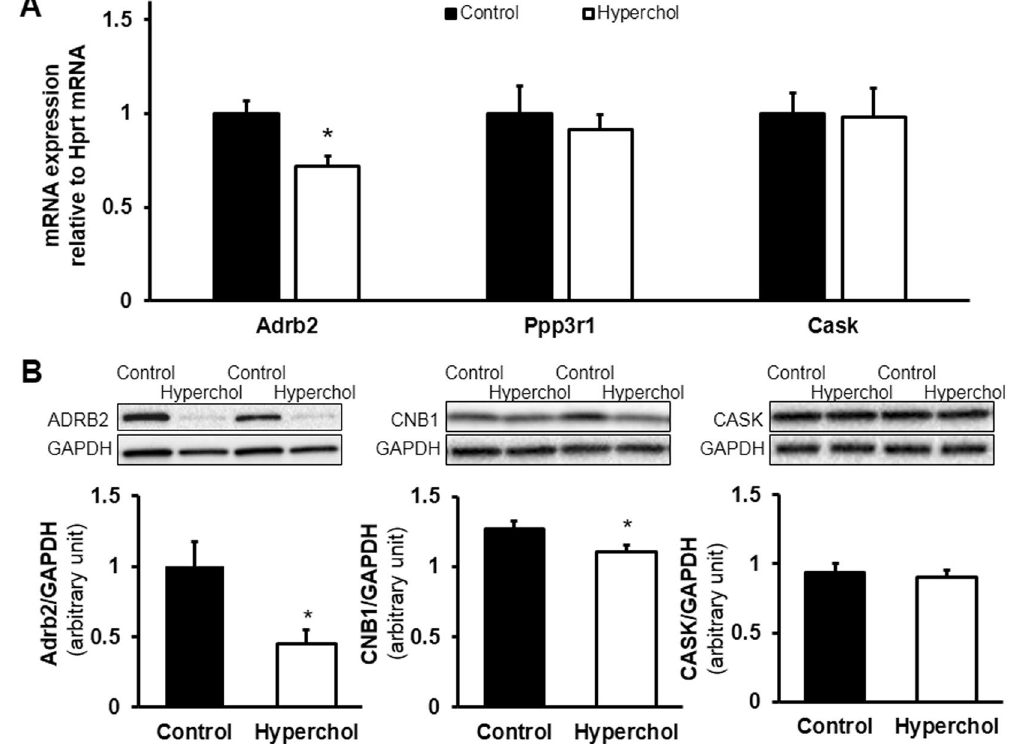
Figure 3. Validation of several predicted miRNA targets. Based on qRT-PCR, Adrb2 mRNA, but not Ppp3r1 and Cask mRNAs, was significantly downregulated by hypercholesterolemia in the heart compared to the control group ( A ). * p < 0.05 vs. Control ( Student’s t-test ). n = 6/group. Calcineurin B type 1 (CNB1) translated from Ppp3r1 mRNA was significantly downregulated in the hypercholesterolemic myocardium compared to the control group ( B ). * p < 0.05 vs. Control ( Student’s t-test ). n = 8–9/group. Western blot images are only representative.